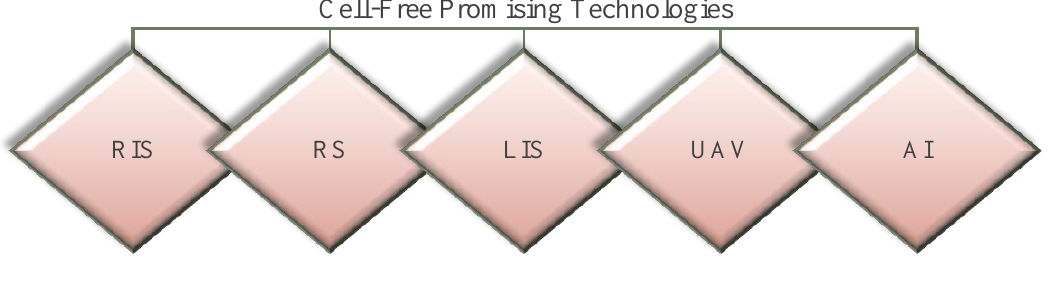
Figure 5. Cell-Free Promising Enabling